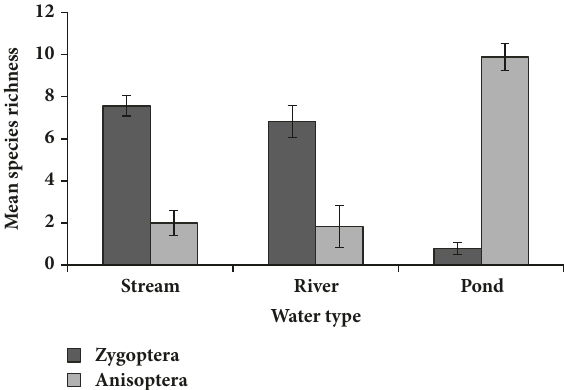
Figure 5: Comparison of mean species richness of the Zygopterans and Anisopterans among the water types.